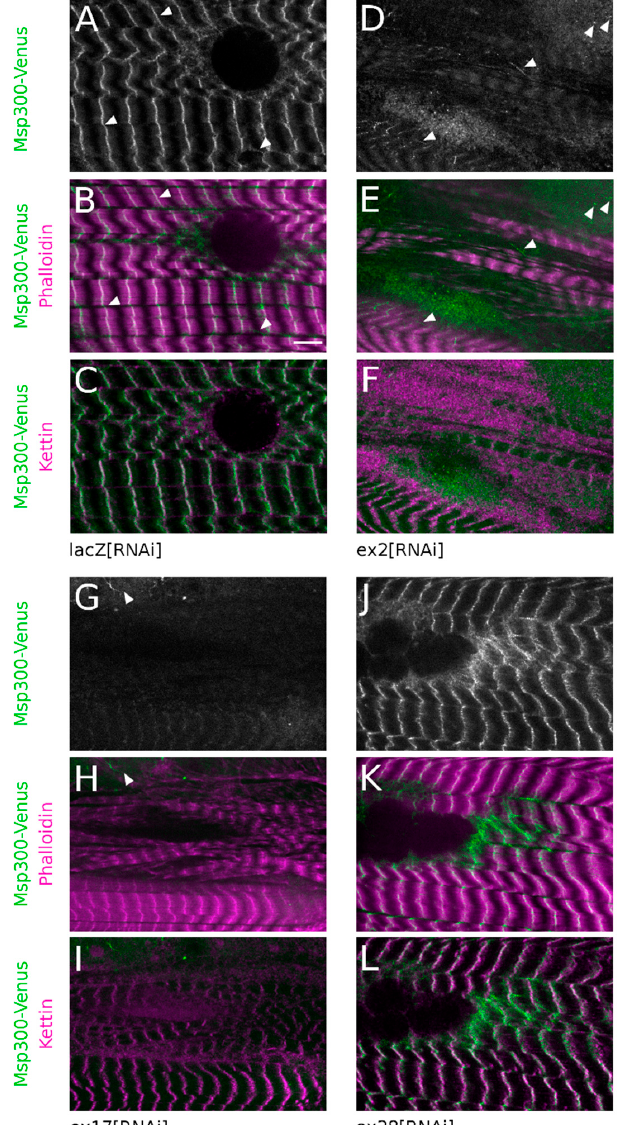
Figure 5. Depletion in CH containing Msp300 isoforms results in disorganisation of the myofibrils. Muscle 4 expressing Msp300-Venus protein-trap together with lacZ[RNAi] ( A – C ), ex2[RNAi] ( D – F ), ex17[RNAi] ( G – I ), or ex28[RNAi] ( J – L ) and showing the contractile apparatus organisation. ( A , D , G , J ): Msp300-Venus localisation. ( B,E,H,K ): phalloidin labelling in magenta and Msp300-Ve- nus fluorescence in green. ( C,F,I,L ): Kettin immunostaining in magenta and Msp300-Venus fluores-